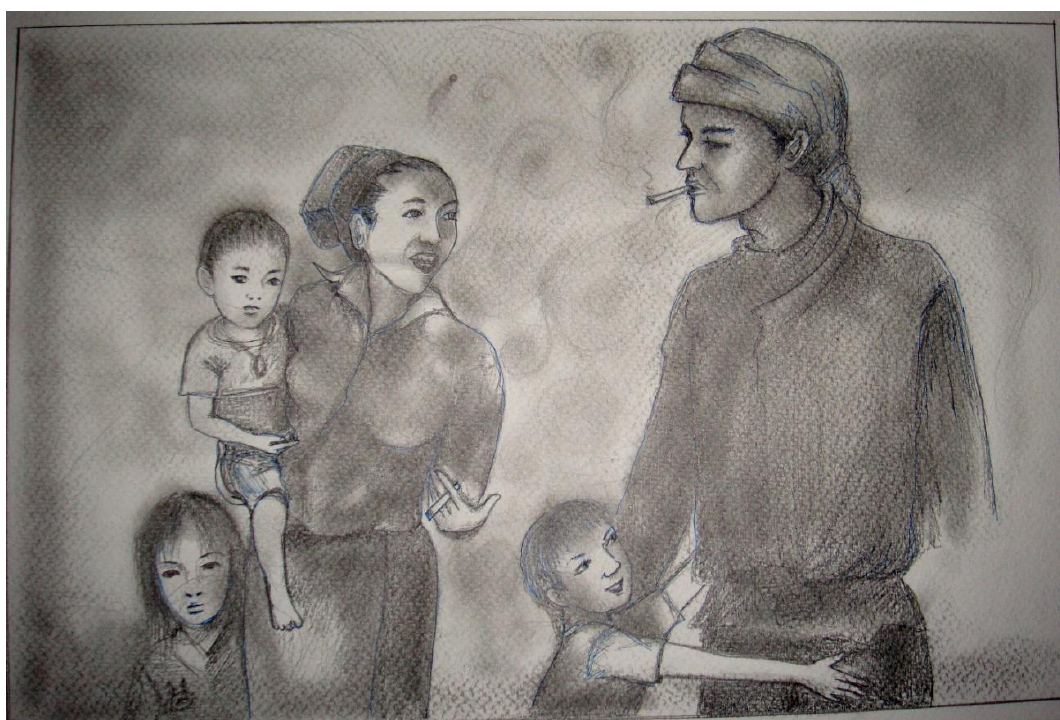
Figure A2. Environmental Tobacco Smoke.